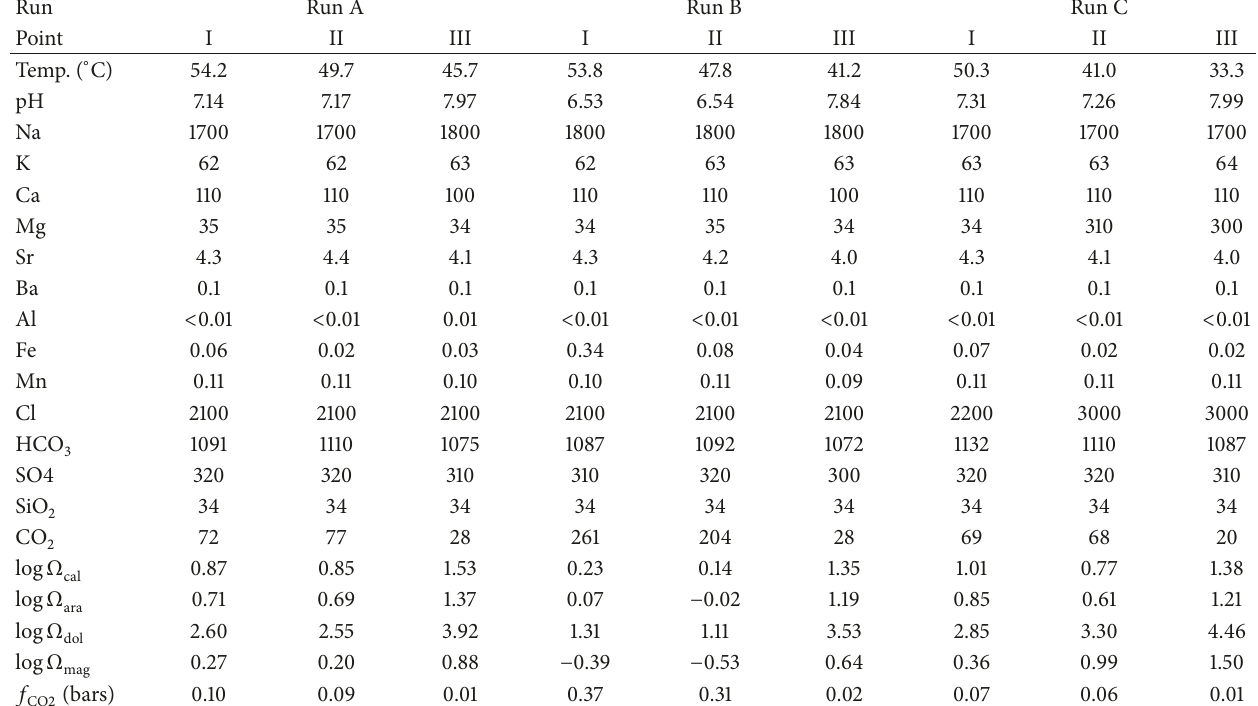
Table 2: Chemical compositions of spring waters at each measurement point in three runs (mg/L).